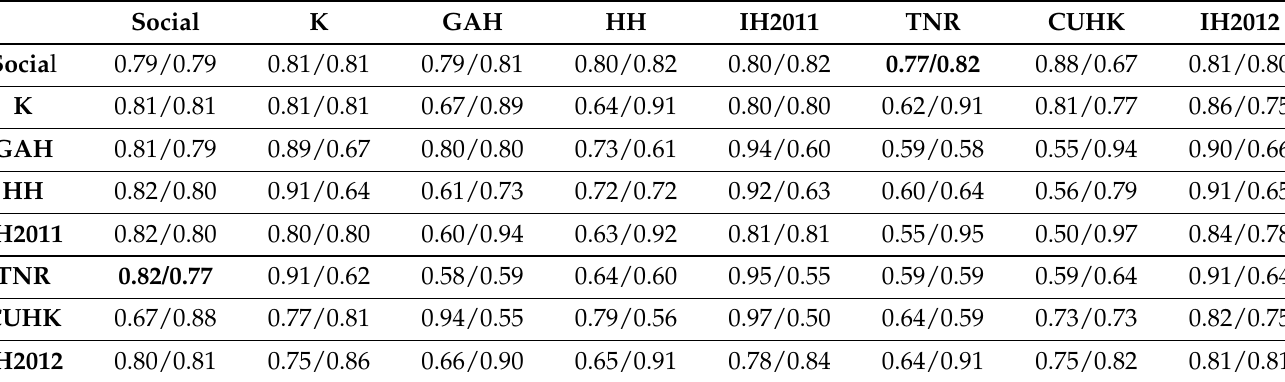
Table 5. Payoff matrix for a bilateral negotiation in an agent society formed by the studied agents. Bold represents the pure equilibrium of the game Social